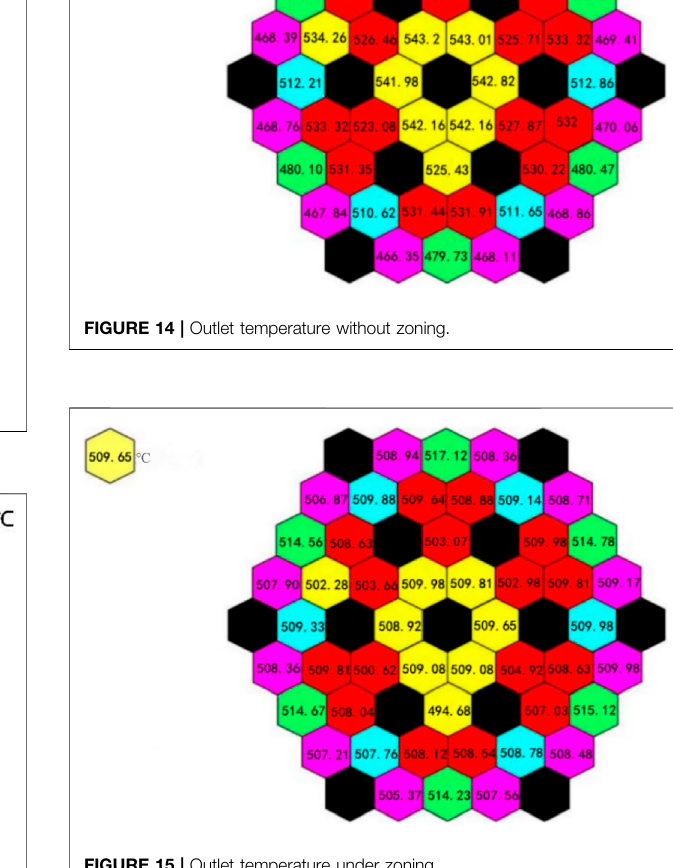
FIGURE 15 | Outlet temperature under zoning.